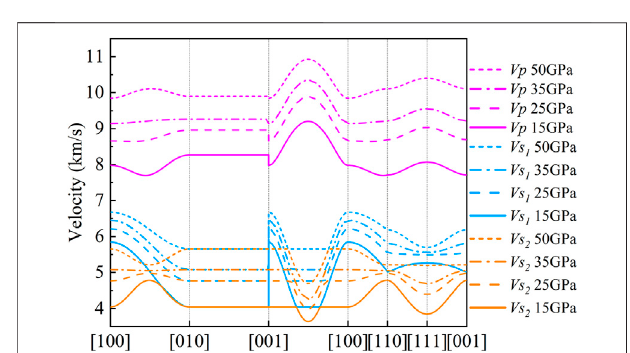
FIGURE 10 | Seismic wave velocity of CaO 3 at different crystal axis directions at 15, 25, 35, and 50 GPa. The solid lines represent 15 GPa, dashedlinesrepresent25 GPa,dot-dashlinesrepresent35 GPa,dottedlines represent 50 GPa, blue represents Vs 1 , orange represents Vs 2 , and magenta represents Vp